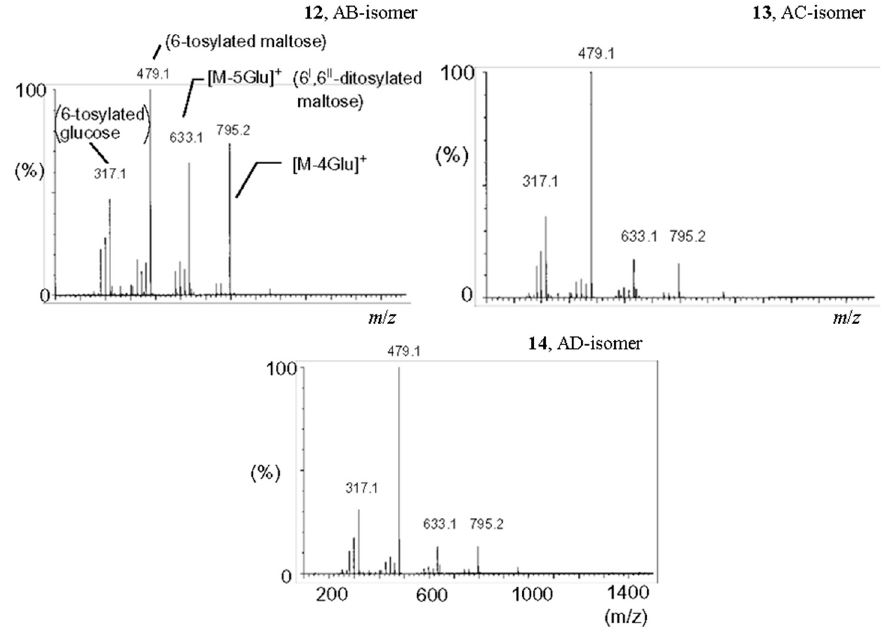
Figure 12. ESI CID MS 2 of [M + H] + ( m / z 1443.4) of three regioisomes of di-6,6 ′ - O , O ′ -tosyl- β -CDs 9a – 11a (reproduced from [15] with permission of SAGE Publications Ltd.).